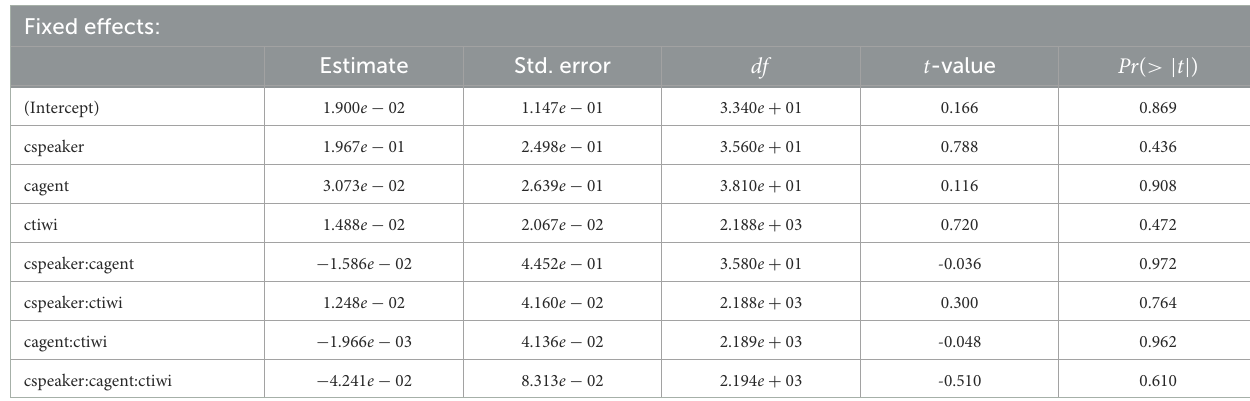
TABLE 7 Coefficients, SE s, df s, t -values, and p -values for the optimal model of logratios of target fixations for the shift time window in Experiment 4, by